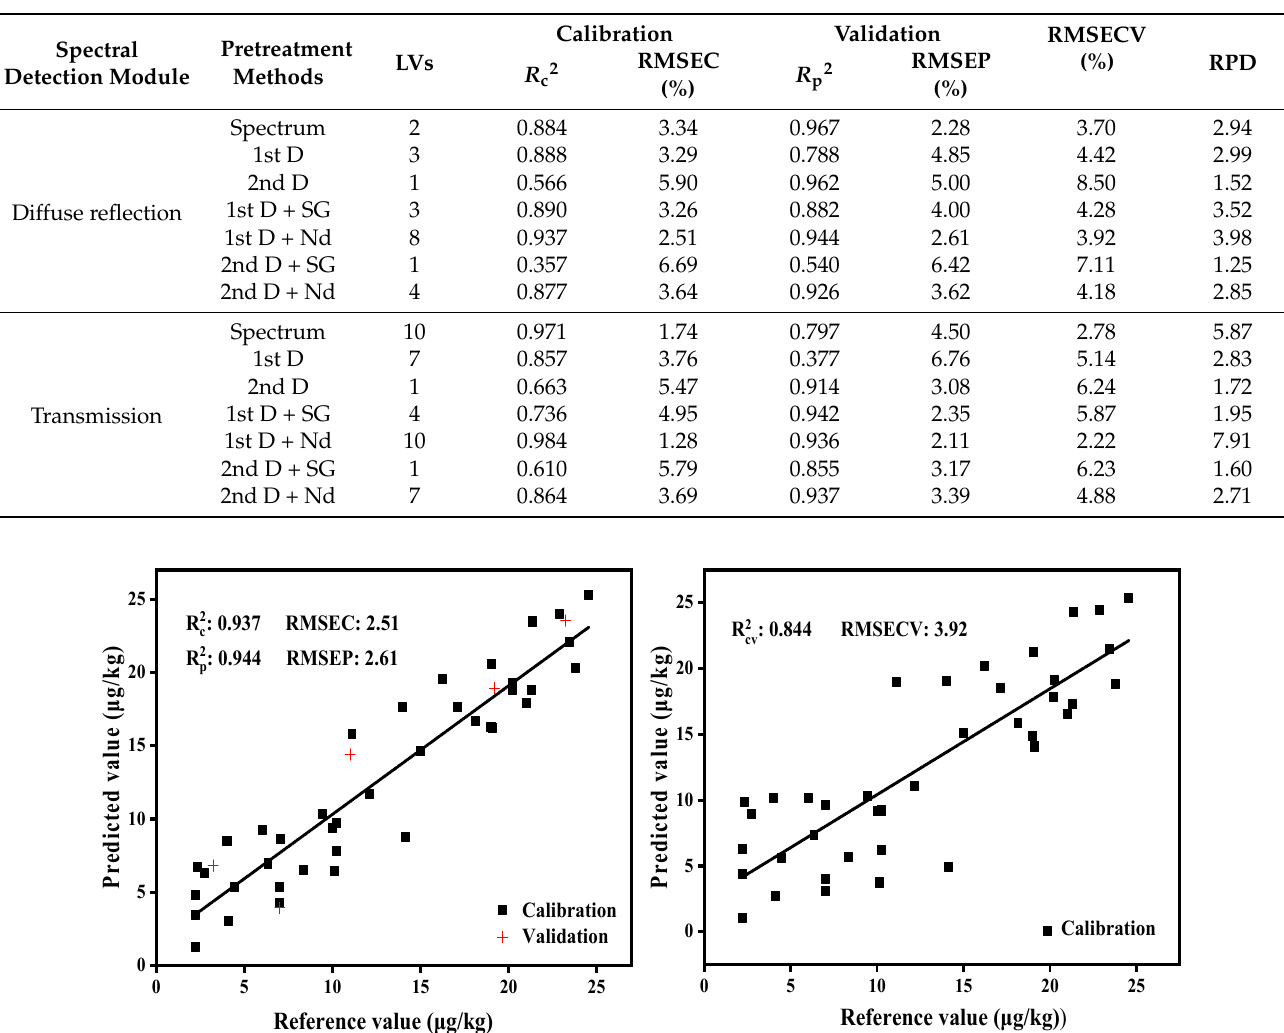
RMSECV: 2.22 Figure 11. PLS model and cross-validation of the transmission module. 2.5.2. External Evaluation of the PLS Models To evaluate the robustness of the PLS models, 30 unknown samples were used for external validation. The spectra obtained from the diffuse reflection and transmission de- tection were entered as input into the calibration equation and prediction was performed. The prediction set and reference values can be seen in Table 4, with the absolute values of the relative deviations for the diffuse reflection and transmission modules being between